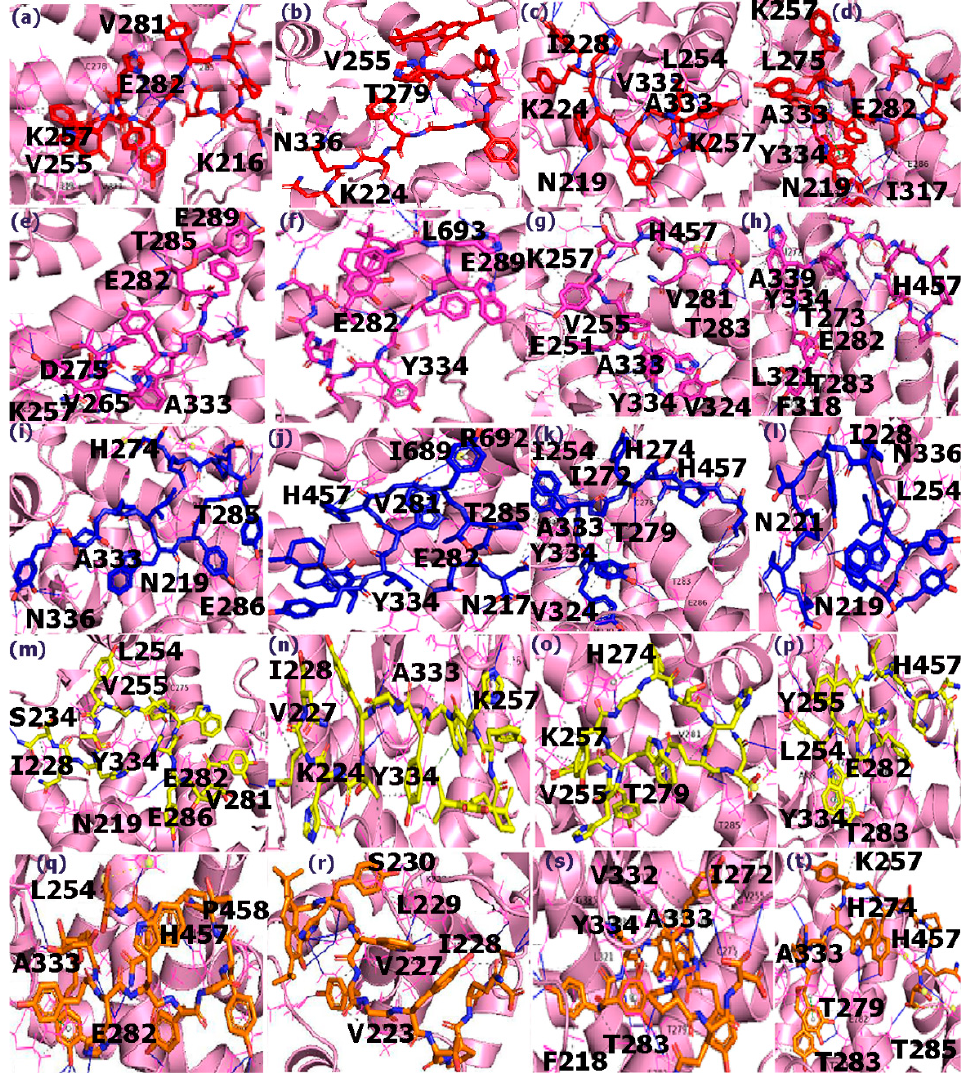
Figure 5. PLIP results for polyphenol peptide conjugates bound to PPAR- α receptor. Pep conjugated with ( a ) cholorogenate; ( b ) carnosate ( c ) gallate ( d ) rosmarinate. Mut1-conjugated with ( e ) cholorogenate; ( f ) carnosate; ( g ) gallate; ( h ) rosmairnate. Mut2-conjugated with ( i ) chlorogenate ( j ) carnosate; ( k ) gallate; ( l ) rosmairnate. Mut 3-conjugated with ( m ) cholorogenate; ( n ) carnosate; ( o ) gal- late; ( p ) rosmairnate; Mut4-conjugated with ( q ) cholorogenate; ( r ) with carnosate; ( s ) gallate; ( t ) ros-